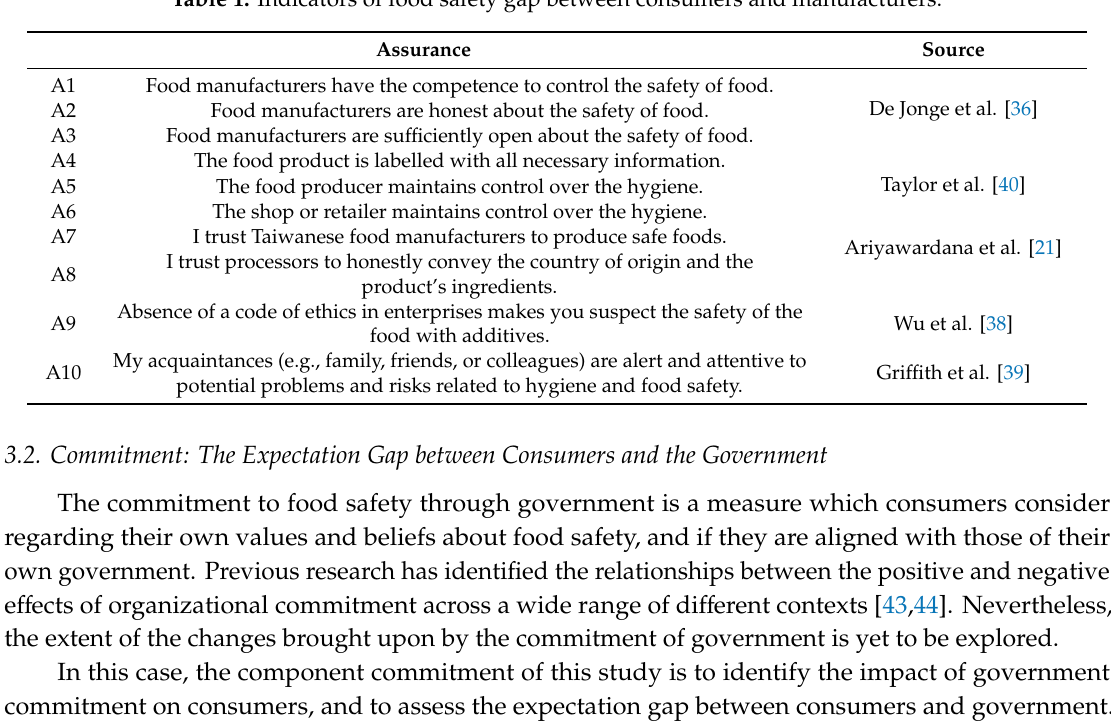
Table 1. Indicators of food safety gap between consumers and